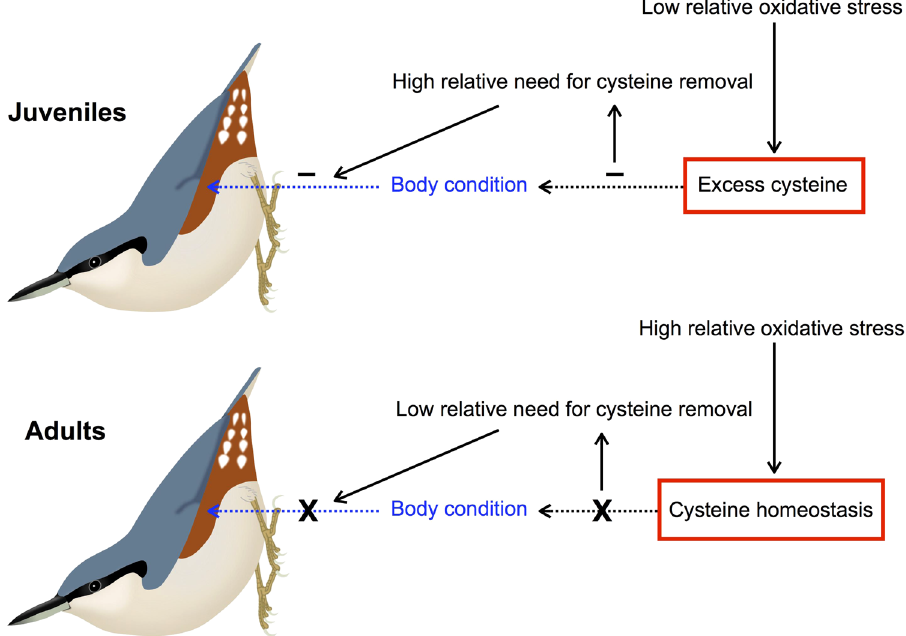
Figure 6. Schematic representation of the detoxifying hypothesis for the evolution of adult-like juvenile plumage coloration based on pheomelanin, exemplified in nuthatches. Solid arrows represent causal effects, and dotted arrows represent relationships whose sign is depicted with a symbol. Juveniles probably tend to suffer low relative oxidative stress as compared to adults, making juveniles more prone to excess cysteine. As excess cysteine is toxic, this may negatively affect the body condition of birds, thus creating a higher need for cysteine removal. In the end, this may lead to negative associations between body condition and the expression of pheomelanin-based plumage coloration, as juvenile birds in poor condition would have a higher need to remove cysteine through the production of pheomelanin for its deposition in feathers. In contrast, adults may have a greater ability to achieve cysteine homeostasis, which would preclude any association between body condition and the expression of pheomelanin-based plumage coloration as found in the present study. As a consequence, plumage in adults may be a developmental consequence of selection operating in juveniles. The same need to remove excess cysteine through pheomelanin synthesis may also explain the evolution of distinctive juvenile plumage coloration, which is commonly produced by pheomelanin. The nuthatch illustration owns to L. Shyamal (https://commons.wikimedia.org/w/index.php?curid = 4253041) and is covered by a CC BY 3.0 license